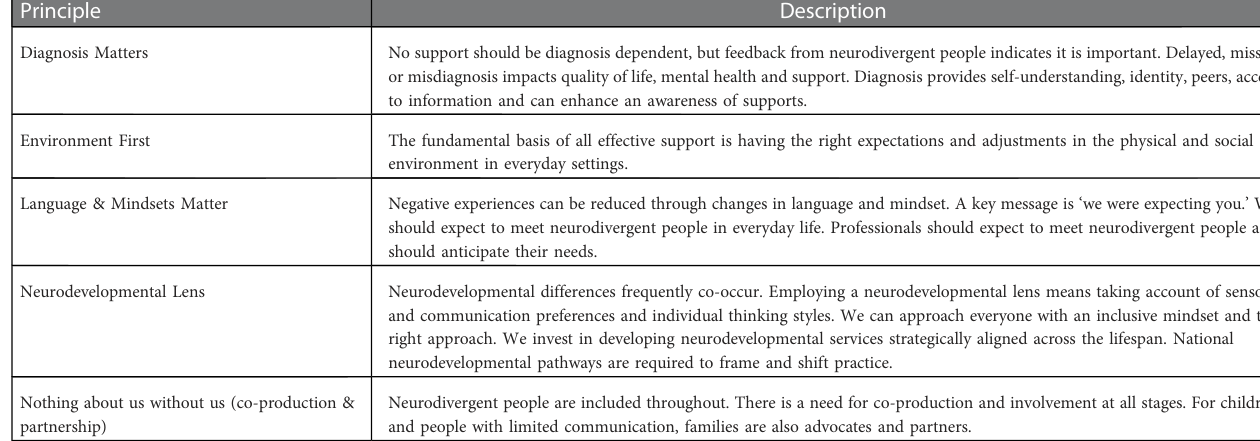
TABLE 2 NAIT principles.